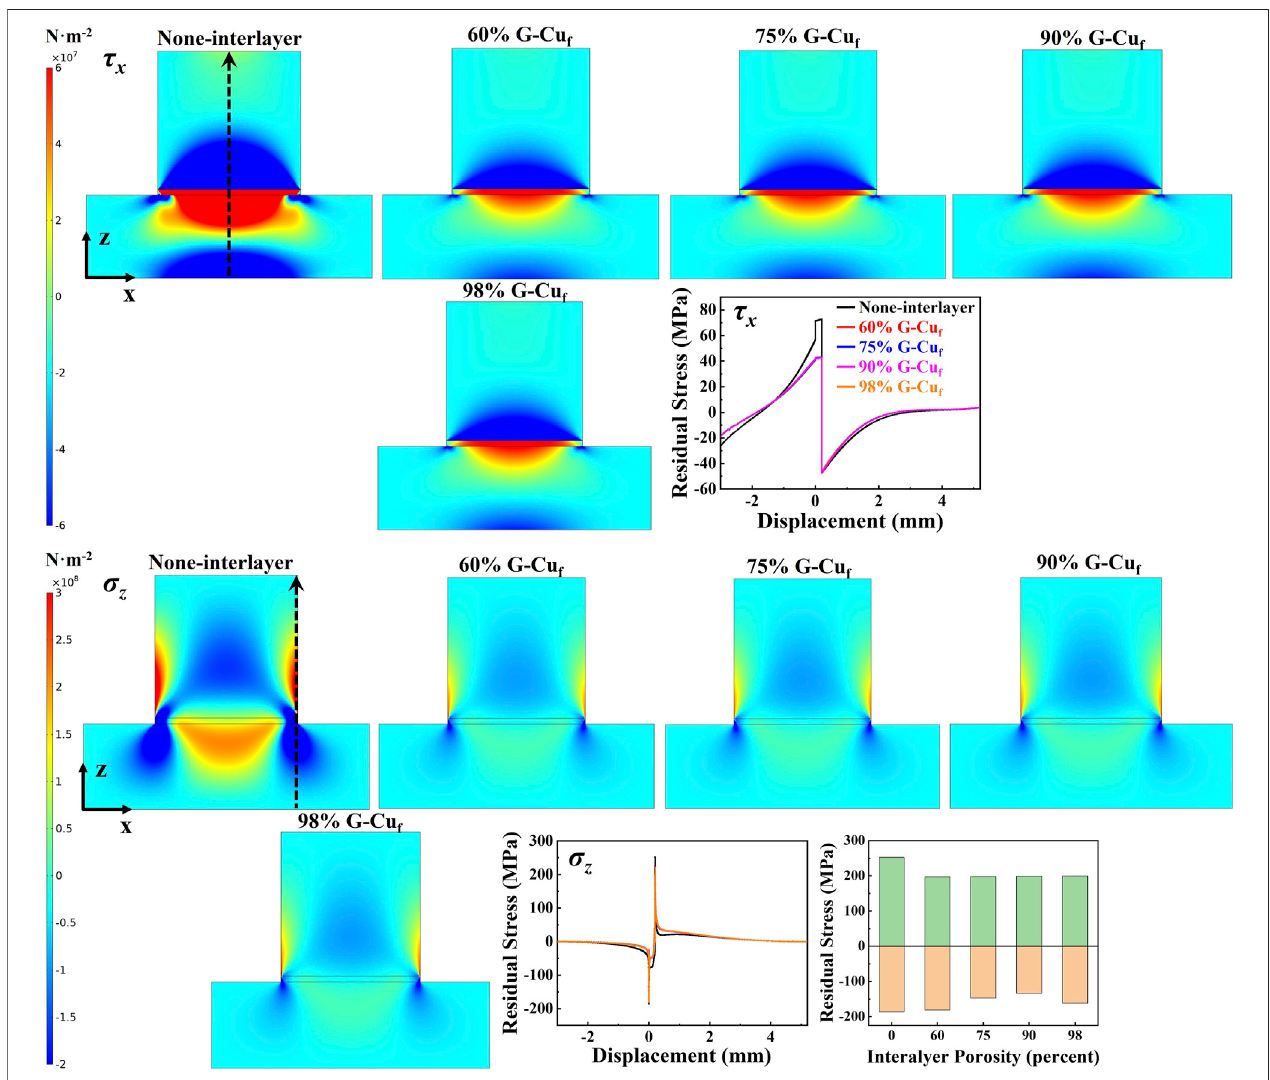
FIGURE 3 | τ x and σ z distribution in C/C-Nb joints brazed with different G-Cu f interlayers differing in porosity.